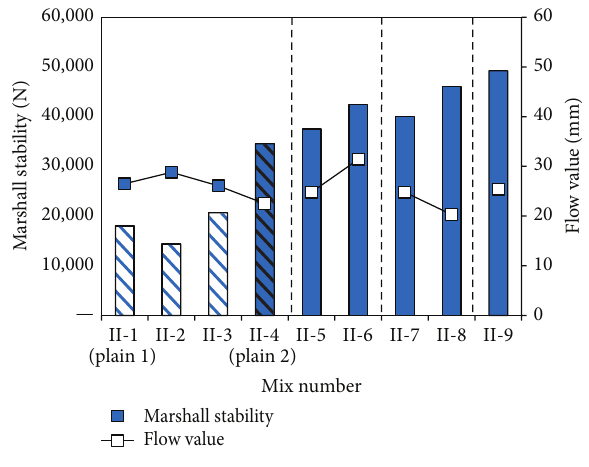
Figure 5: Marshall stability and flow value.